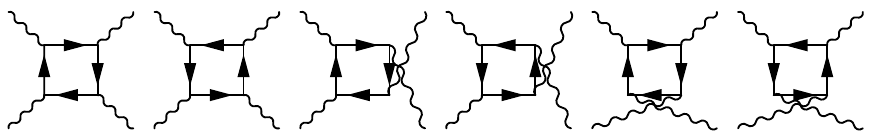
Figure 3. Quark-loop contribution to HLbL